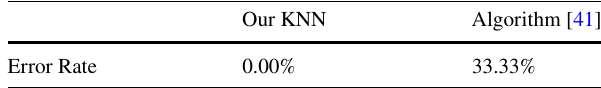
Table 12 Error rate comparison on Experiment 1